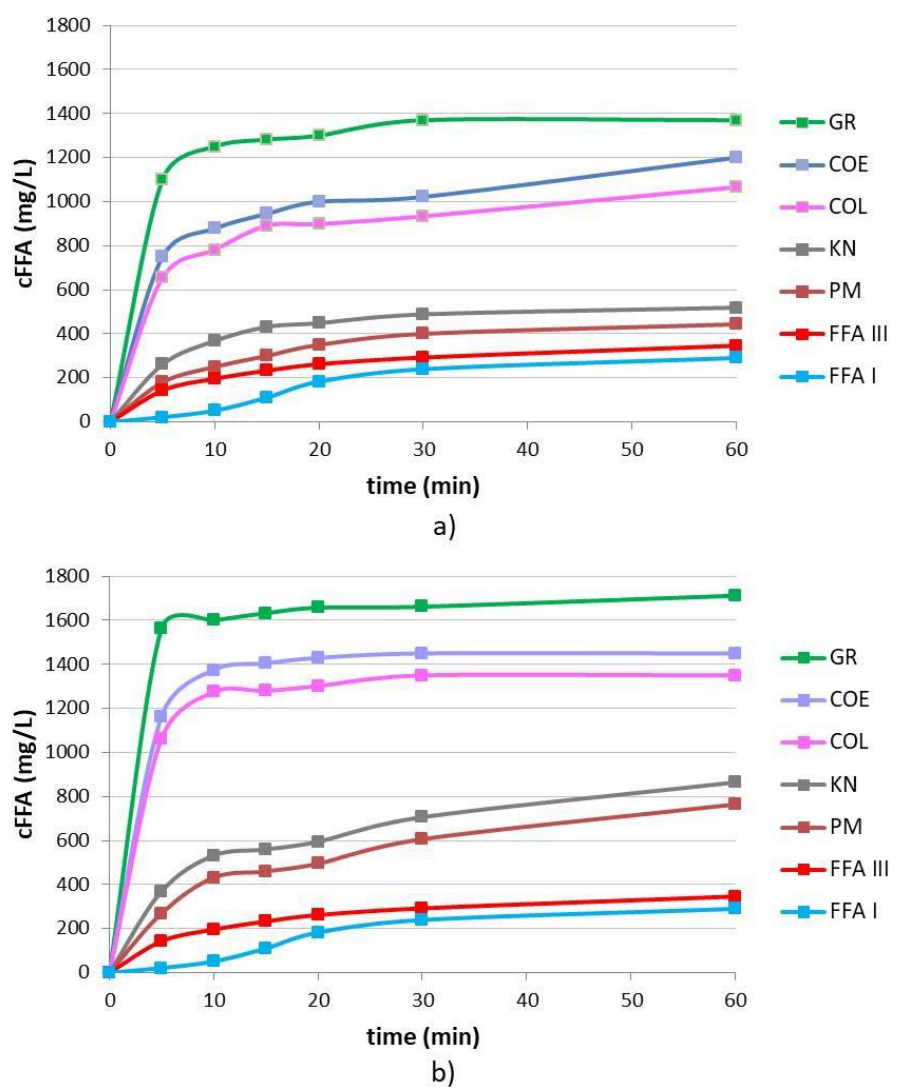
Figure 3. Dissolution curves of FFA alone (Form I) or from its binary systems prepared by physical mixing (PM), kneading (KN), co-lyophilisation (COL), co-evaporation (COE) or co-grinding (GR) with HPβCD ( a ) or RAMEB ( b ). The dissolution curve of FFA Form III is also shown.